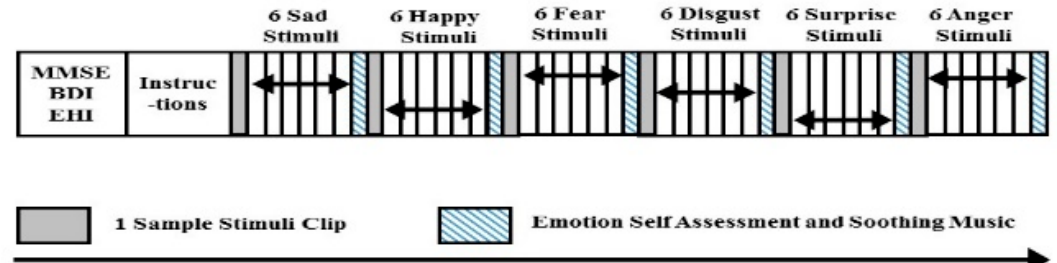
Figure 3. Data collection protocol.